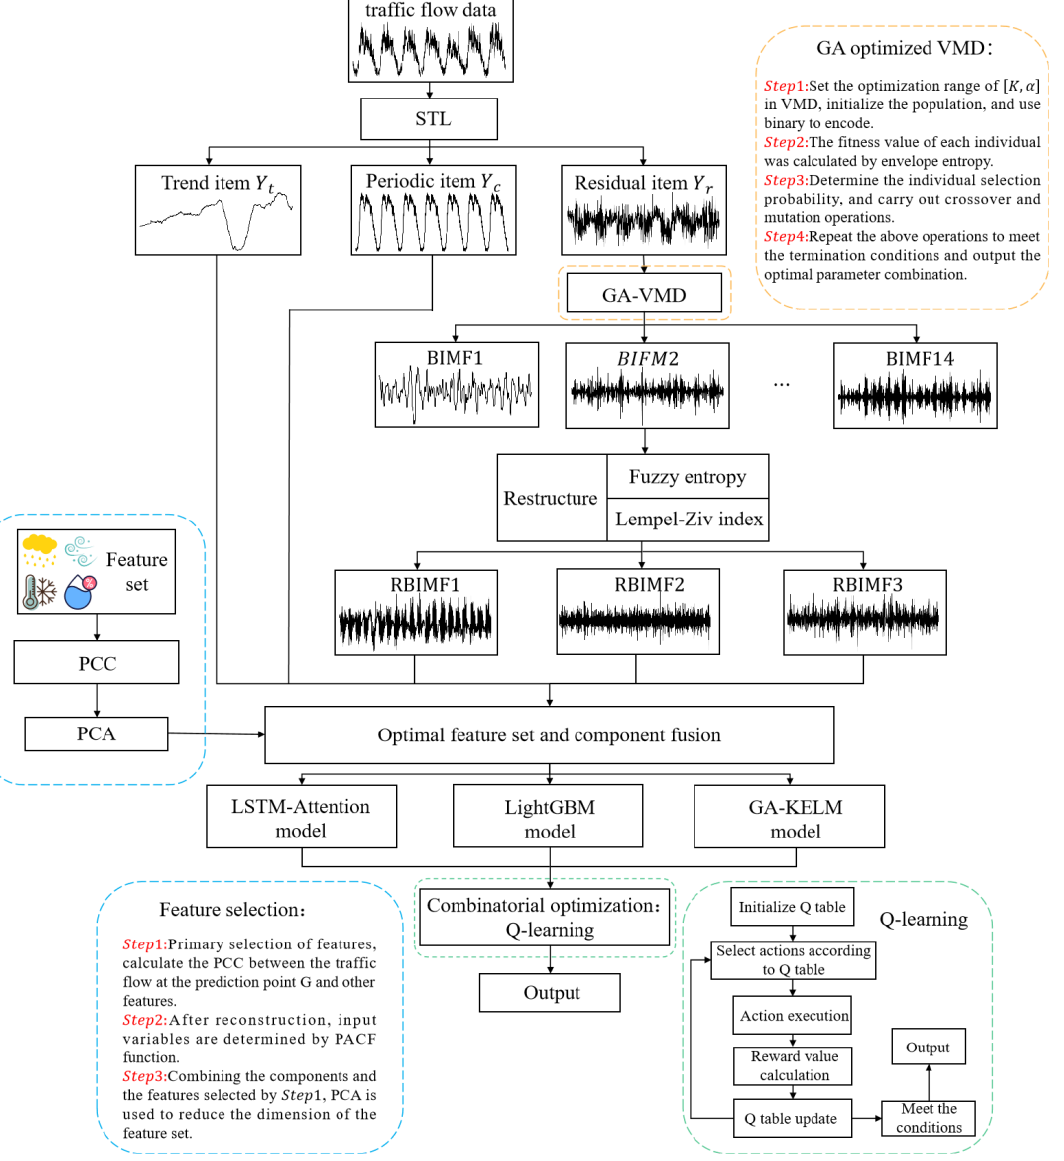
Figure 3. Short-time traffic flow combination forecasting model.